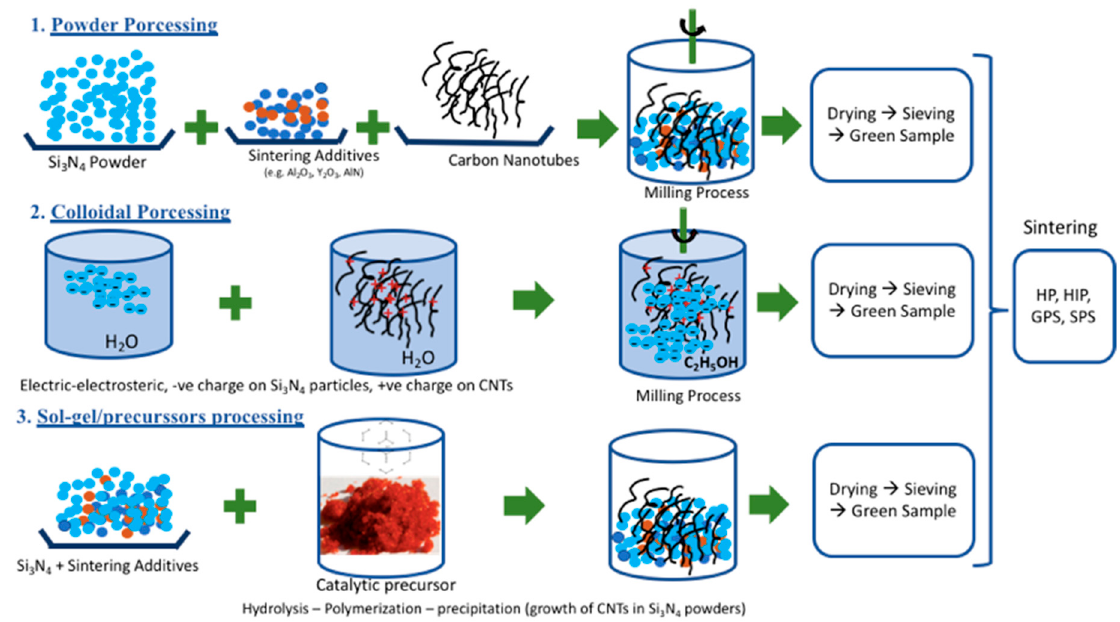
Figure 3. Illustration of the main processing routes used for the processing of Si 3 N 4 + CNT composites.